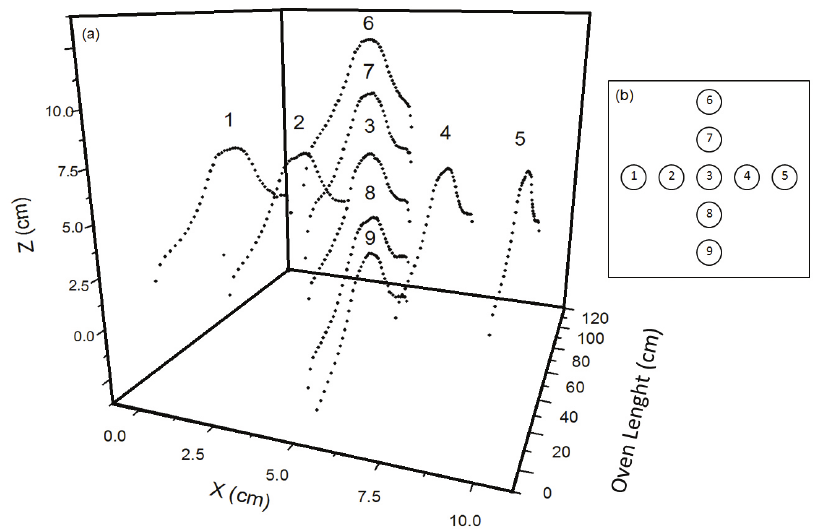
Figure 4. (a) Oven temperature behavior along each tube and (b) Related oven holes labelled by their different positions.